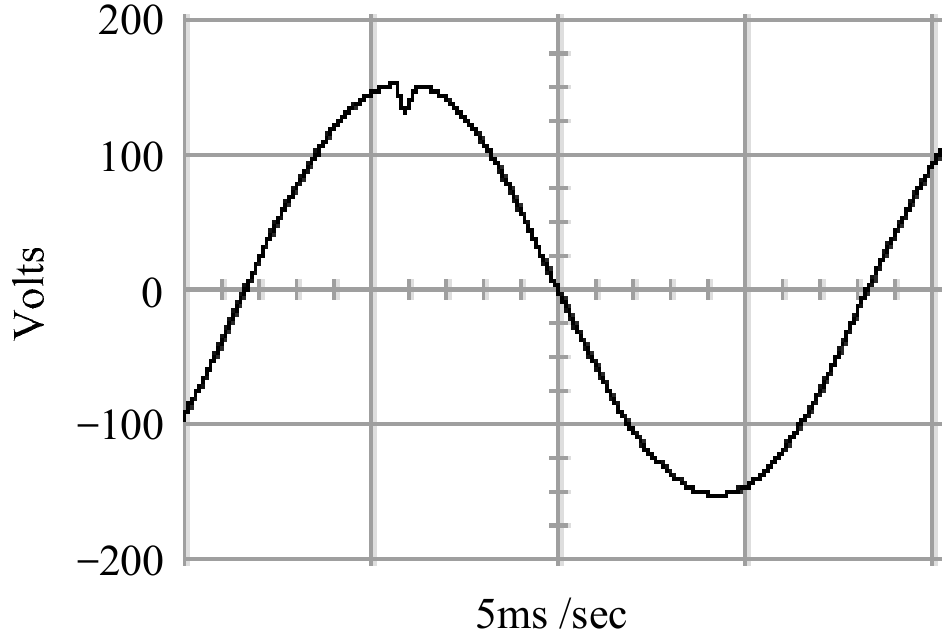
Figure 12. Experimental output voltage with the proposed technique under stepped load.